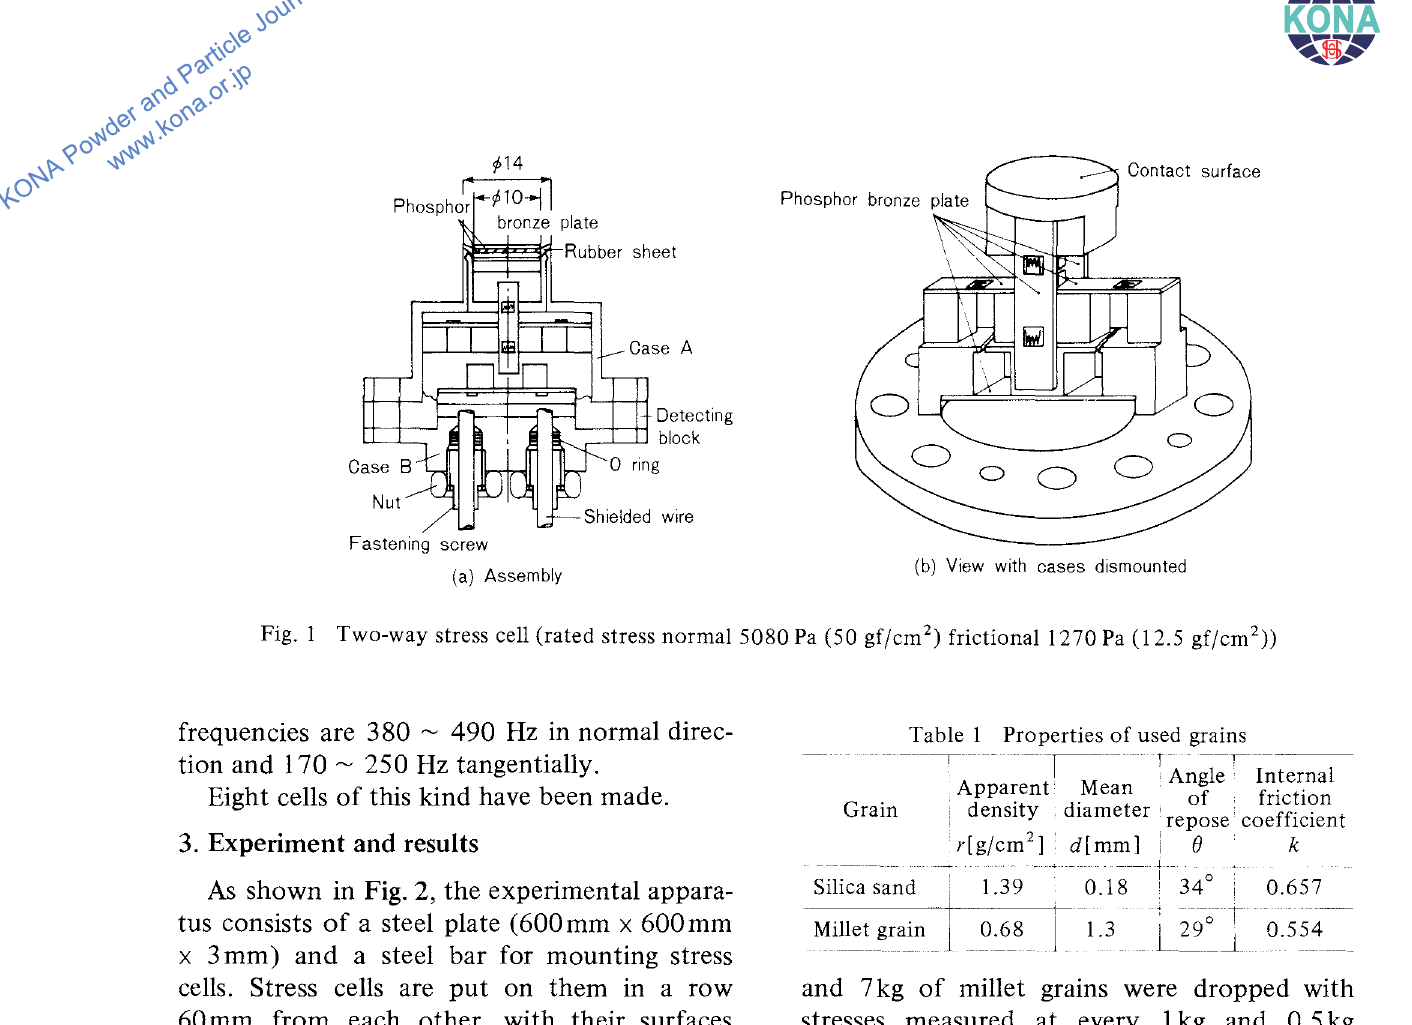
Fig. 1 Two-way stress cell (rated stress normal 5080 Pa (50 gfjcm 2 ) frictional 1270 Pa (12.5 gf/cm 2))